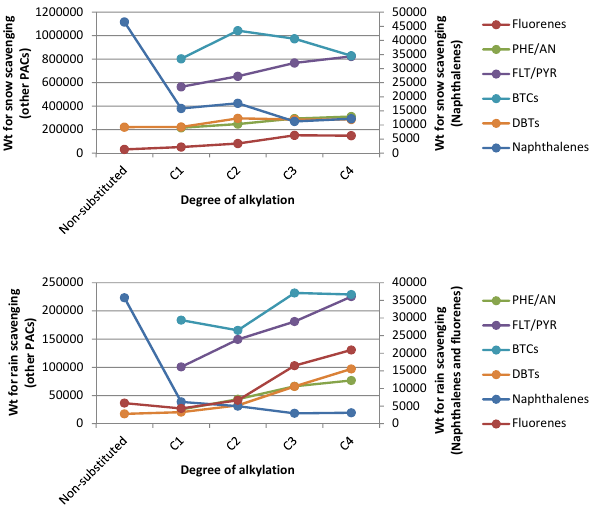
Figure 6. Effect of alkylation on total scavenging ratios ( W t ) for snow and rain. PHE_AN = phenanthrenes/anthracenes, FLT_PYR = fluoranthenes/pyrenes, BTC = benz( a )anthracenes/triphenylenes/chrysenes, DBT =